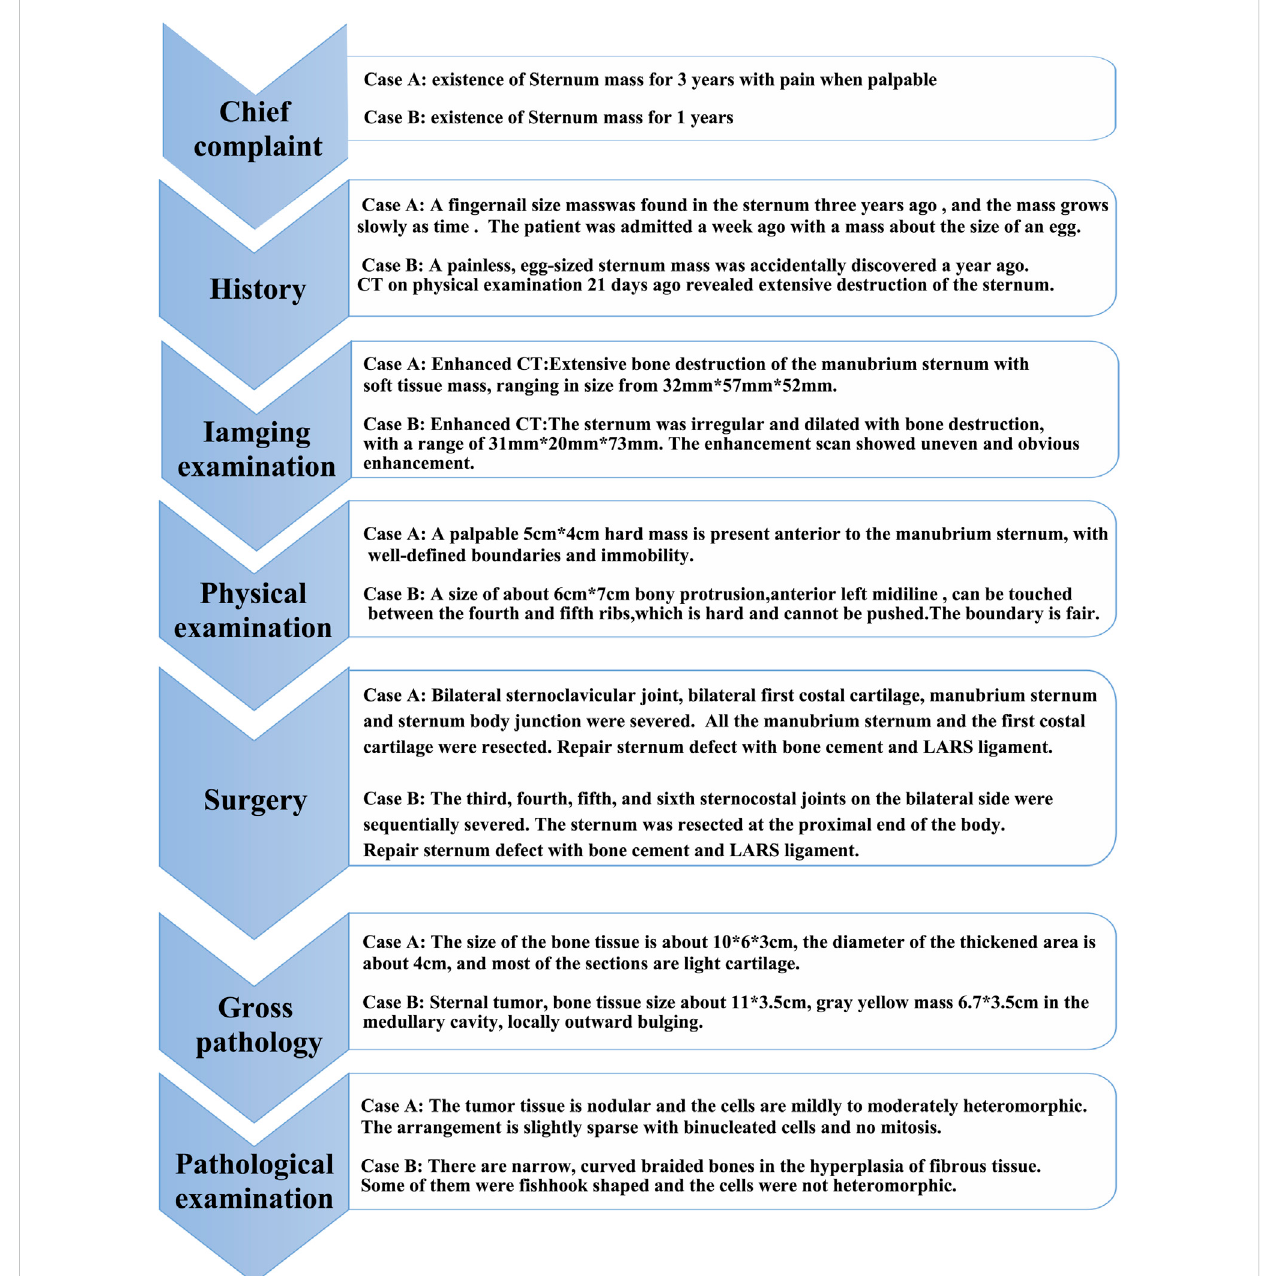
FIGURE 4 The therapeutic course of our patient. The current case series is presented based on this sequence of events.